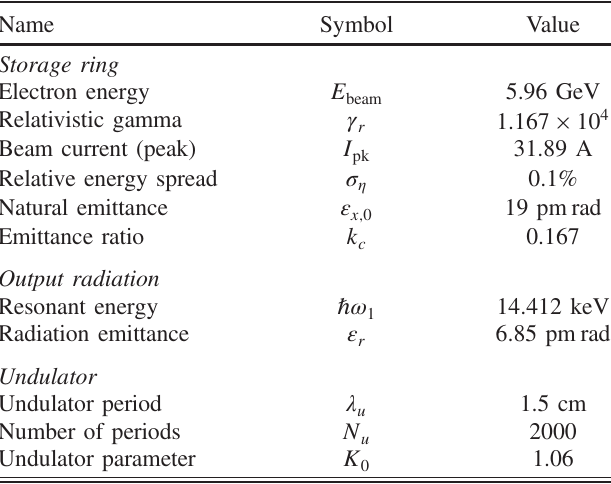
TABLE I. Machine parameters used for optimization study. Storage ring parameters are derived from PETRA-IV [6,10].